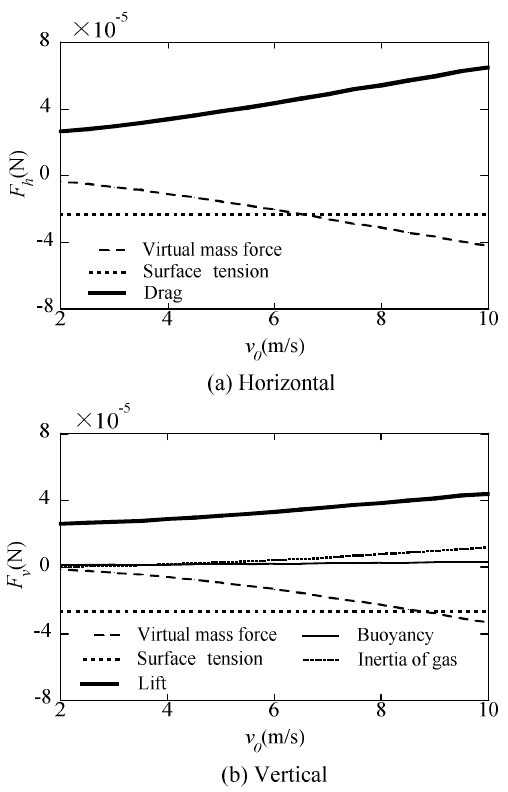
Fig. 12 Forces acting on the bubble ( d